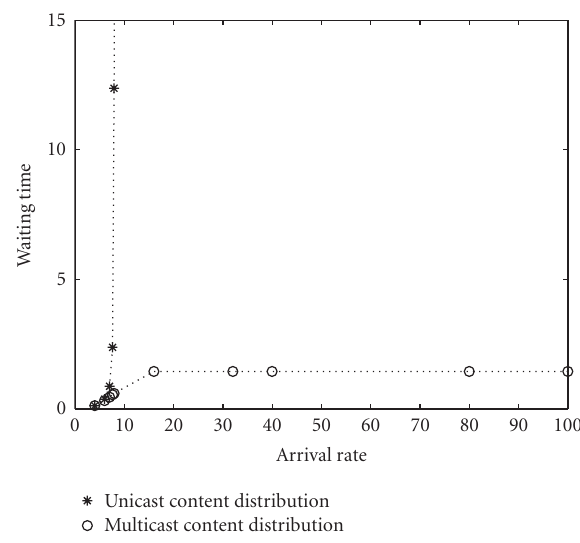
Figure 2: The expected waiting time o ff ered by multicast con- tent distribution, and by unicast content distribution methods, as a function of the arrival rate to the system, for a homogeneous load distribution.